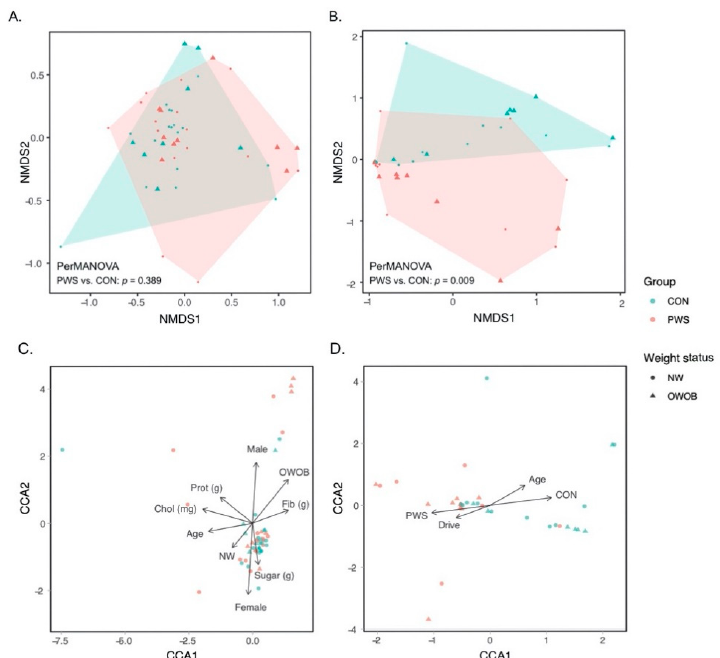
Figure 1. Phylum-level relative abundance in bacterial communities ( A ) and fungal communities ( B ). Linkages between the microbial community and environmental variables. The first two axes of the canonical correspondence analysis (CCA) display bacterial ( C ) and fungal ( D ) community (dots) and phenotypes (arrows) with significant linkage ( p < 0.05). PWS: Prader–Willi syndrome; CON: control. Arrows show the level and direction of impact of significant factors.